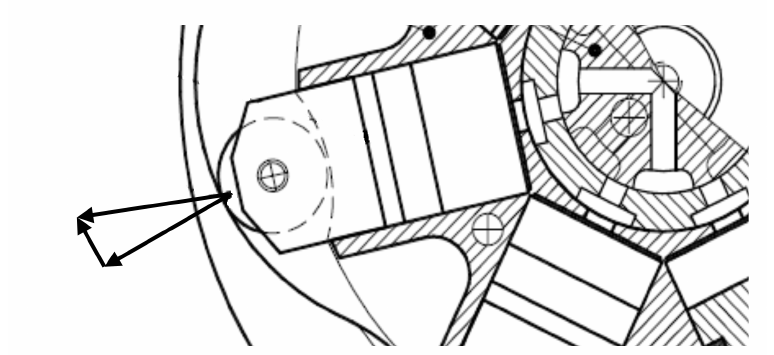
Figure 2. Driving force of the motor rotation.